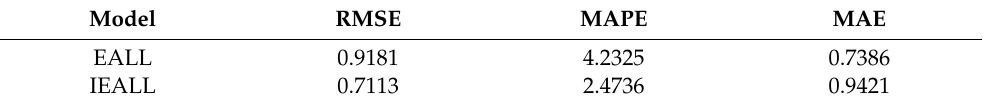
Table 6. The evaluation results of IEALL model and EALL models.